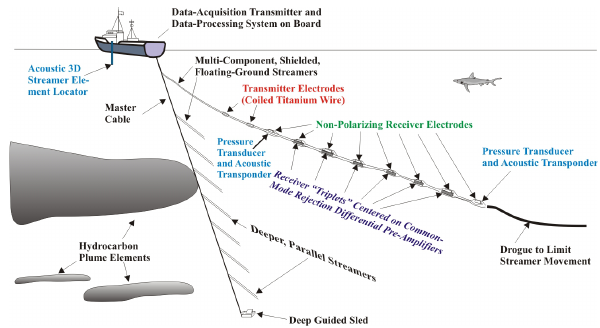
Fig. 1. The topological equivalence of a classical capacitor with an oil-based dielectric, and oil dispersed in conductive seawater, sug- gests that oil should display capacitive behavior under an inducing voltage from a towed geoelectrical array.